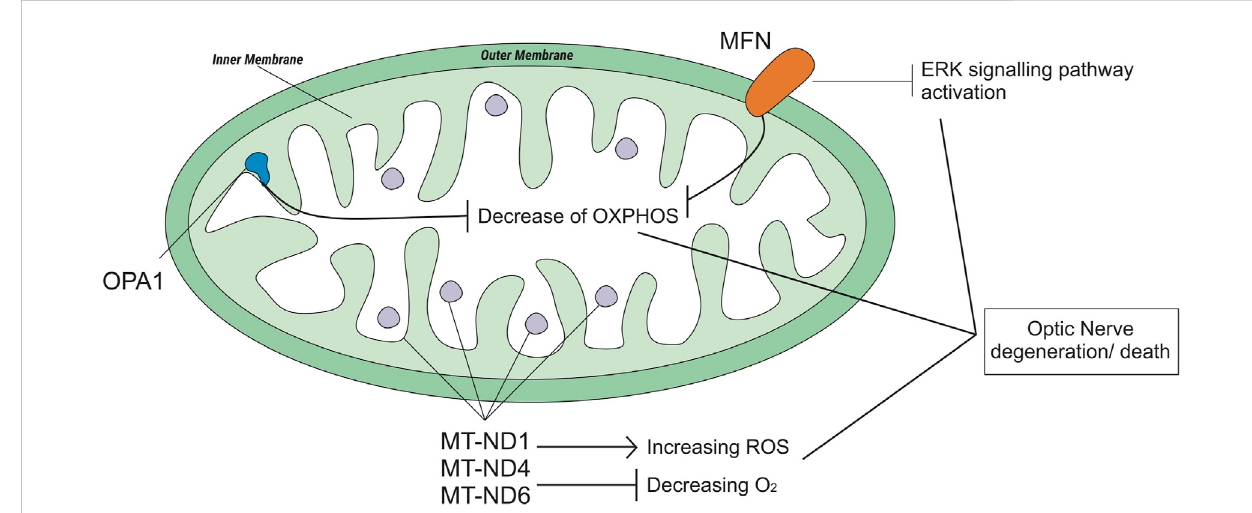
FIGURE 4 Genetic polymorphisms related to optic neuropathy which is regulated by the mitochondrial